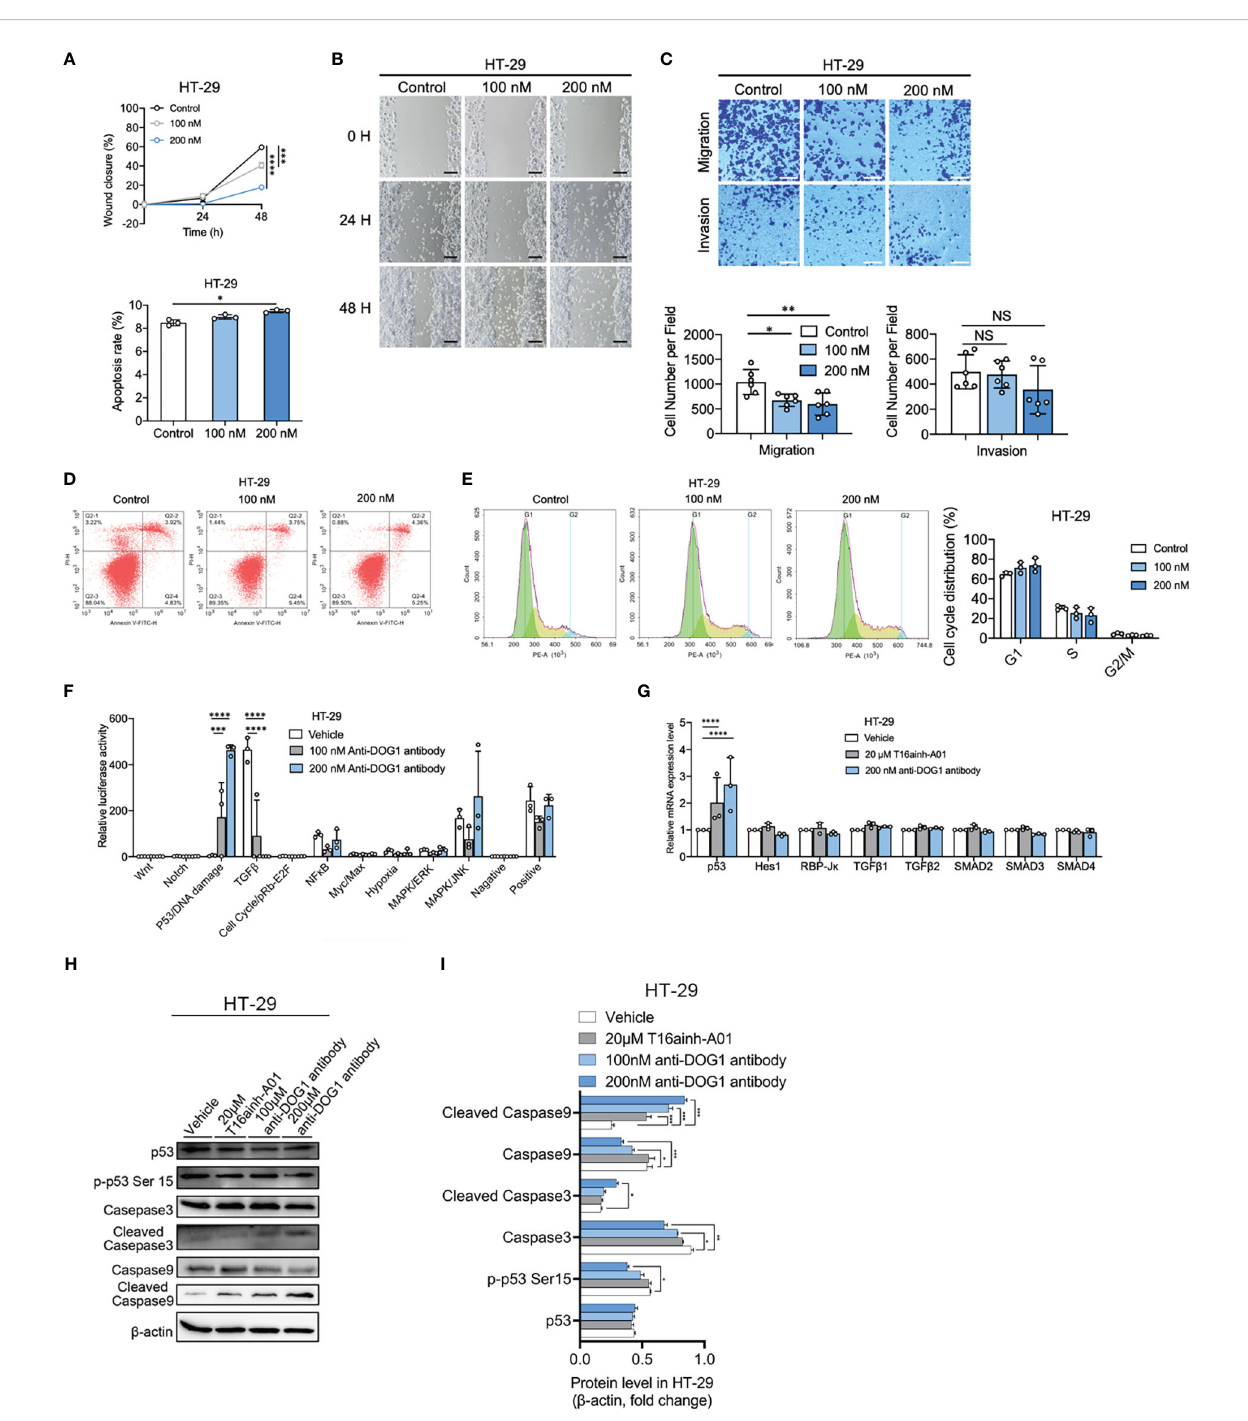
FIGURE 3 Anti-DOG1 antibody induced cell apoptosis and inhibited cell migration and invasion through p53 signaling pathway in HT-29 colon cancer cells. (A) The wound closure for HT-29 and GIST-882 was quanti fi ed at every 24 h post-wound (mean ± S.E.M., n = 6); (B) Representative image of wound healing assay in HT-29 cells at 0 h, 24 h and 48 h post wounding. The cells were treated with 100 nM and 200 nM anti-DOG1 antibody. Scale bar, 500 m m; (C) Migration (without Matrigel) and invasion (with Matrigel) of HT-29 cells were suppressed by the anti-DOG1 antibody compared with the control as shown by Transwell assays. Representative images are shown. Scale bar, 100 µm. Bar graphs of panel C are shown. Values are the mean ± SD; n=6; (D) Anti-DOG1 antibody-induced apoptosis in HT-29 cells. Apoptotic cells were quanti fi ed by Annexin V/PI double staining assay. HT-29 cells are treated with vehicle, 100 nM and 200 nM anti-DOG1 antibody for 48 h. Analysis on cell apoptosis results of I (n=3); (E) Flow cytometric analysis of the cell cycle distribution in HT-29 cells treated with vehicle, 100 nM and 200 nM anti-DOG1 antibody for 48 h. Bar graphs showing an increase of G1 phase and a decrease of S phase in cell cycle for the percentage of indicated cells in K (n=3), but without statistical signi fi cance; (F) Expression levels of 10 major cell signaling pathways in HT-29 cells treated with anti-DOG1 antibody. Values are the mean ± SD; n=3; (G) Relative mRNA-level of p53, Notch and TGF b signaling of HT-29 cells after 48 h treatment with vehicle, 20 m M T16ainh-A01 and 200 nM anti-DOG1 antibody as determined by qRT-PCR. Data are normalized to the respective vehicle control and represent the mean ± SD; n=3; (H) Immunoblots of lysates from the HT-29 cell lines after 48 h treatment with vehicle, 20 m M T16ainh-A01, 100nM and 200 nM anti-DOG1 antibody. b -actin was used as control; (I) Bar graph showing quantitative analysis of protein expressions (n=3). Data were normalized by b -actin. Compared with the control group by one-way ANOVA. *P < 0.05; **P <0.01; ***P <0.001; ****P